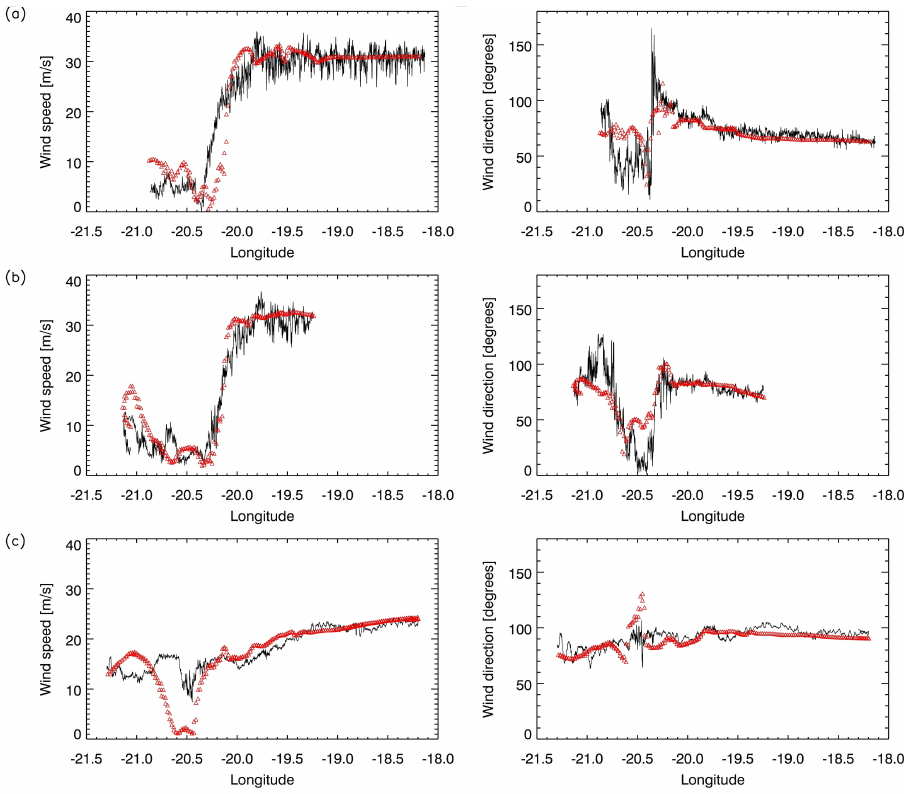
Fig. 10. Aircraft measurements (black lines) and G3 simulations from the run MPR (red triangles) at (a) 400m height, (b) 700m height and (c) 1900m height. Wind speed [ms − 1 ] is shown by panels on the left and wind direction [degrees] by panels on the